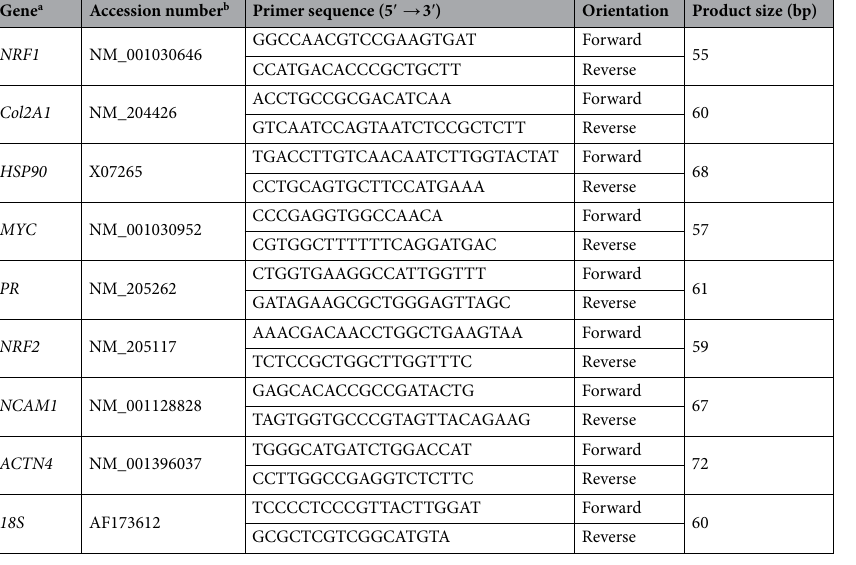
Table 1. Oligonucleotide QPCR primers. a ACTN4, α-actinin 4; Col2A1, collagen type II alpha 1 chain; HSP90, heat shock protein 90; MYC, myelocytomatosis oncogene; NCAM1, neural cell adhesion molecule 1; NRF1/2, NFE2 like bZIP transcription factor ½; PR, progesterone receptor. b Accession number refer to Genbank